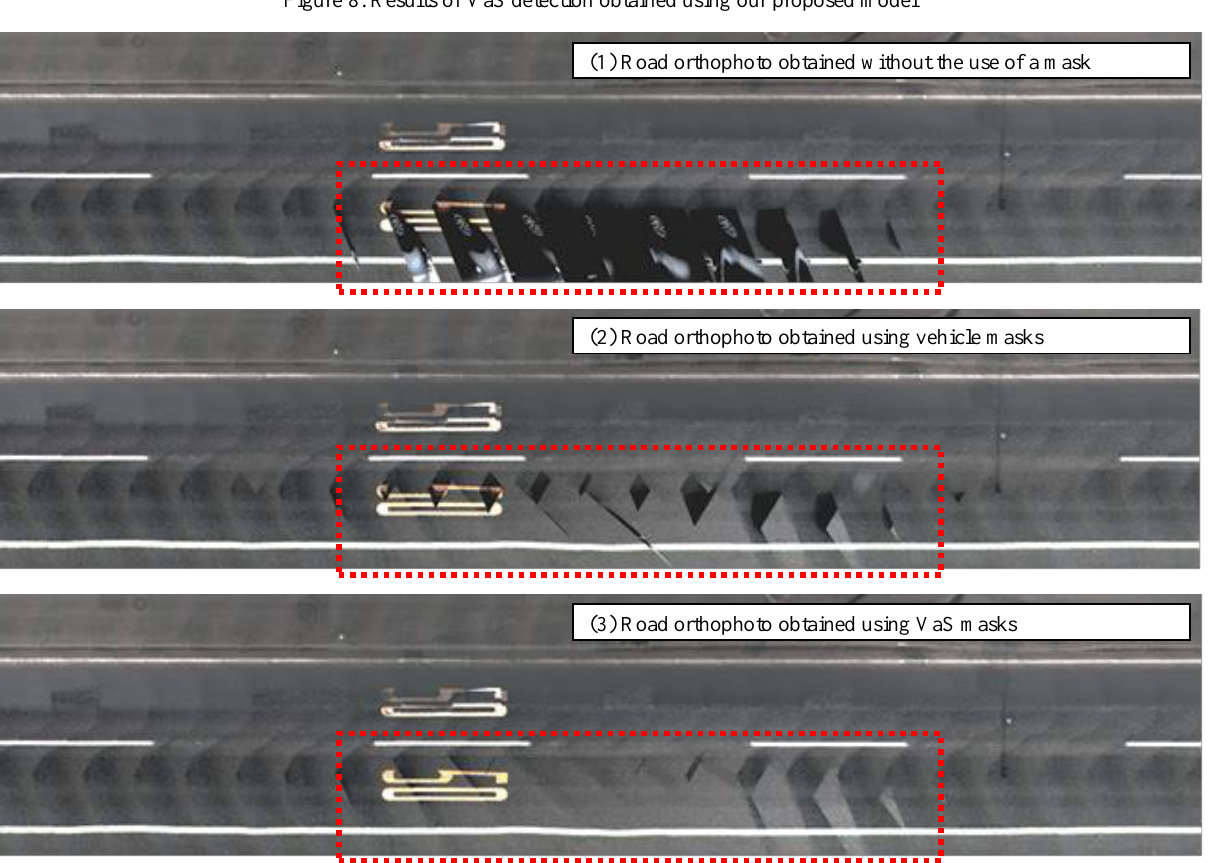
Figure 9. Comparison of road orthophotos obtained (1) without the use of a mask, (2) using vehicle masks, and (3) using VaS